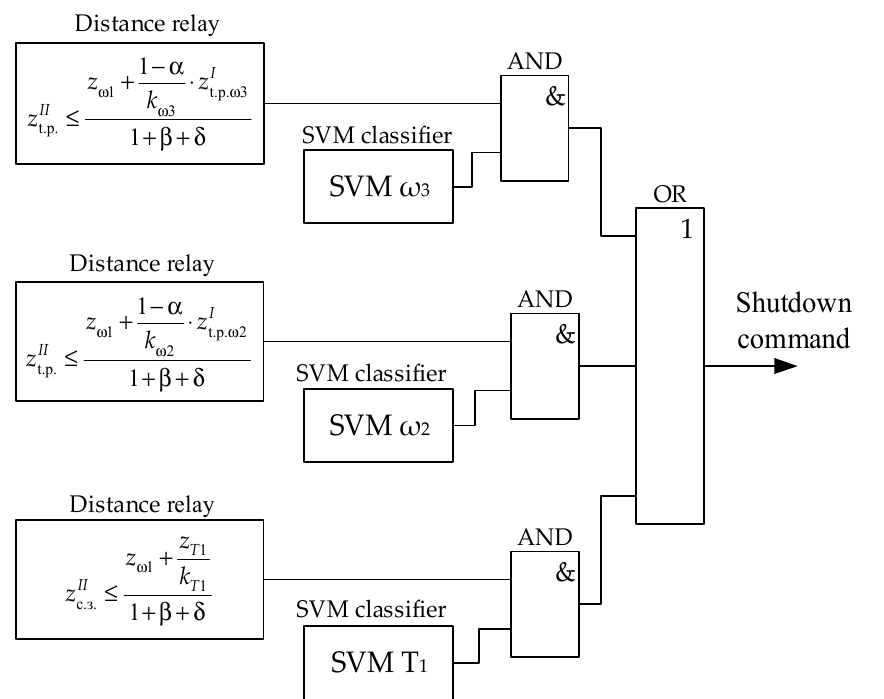
Figure 16. Combination of independent stages of DP with additional triggering elements.